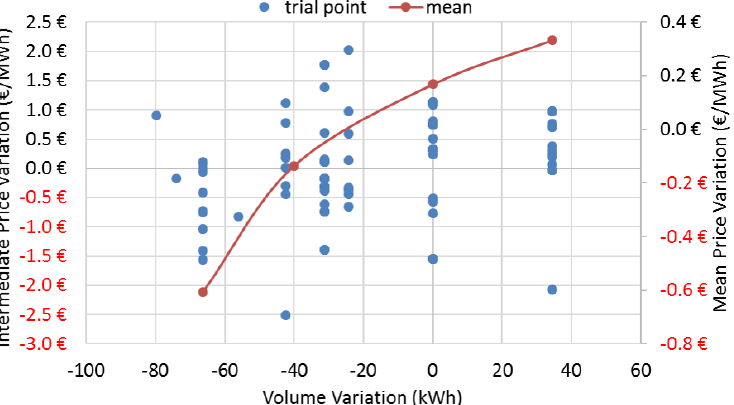
Figure 4. Retailer response to the consumption variation of the consumer in the intermediate